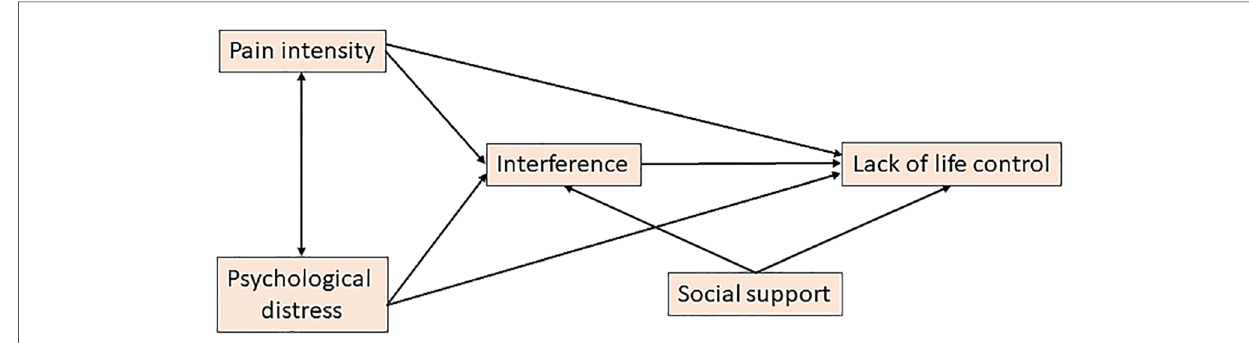
FIGURE 1 The theoretical model. Constructs/latent variables are shown together with the paths including directions. For the pain intensity-psychological distress relationship, two options (models) are explored (here indicated by a line with an arrowhead at either